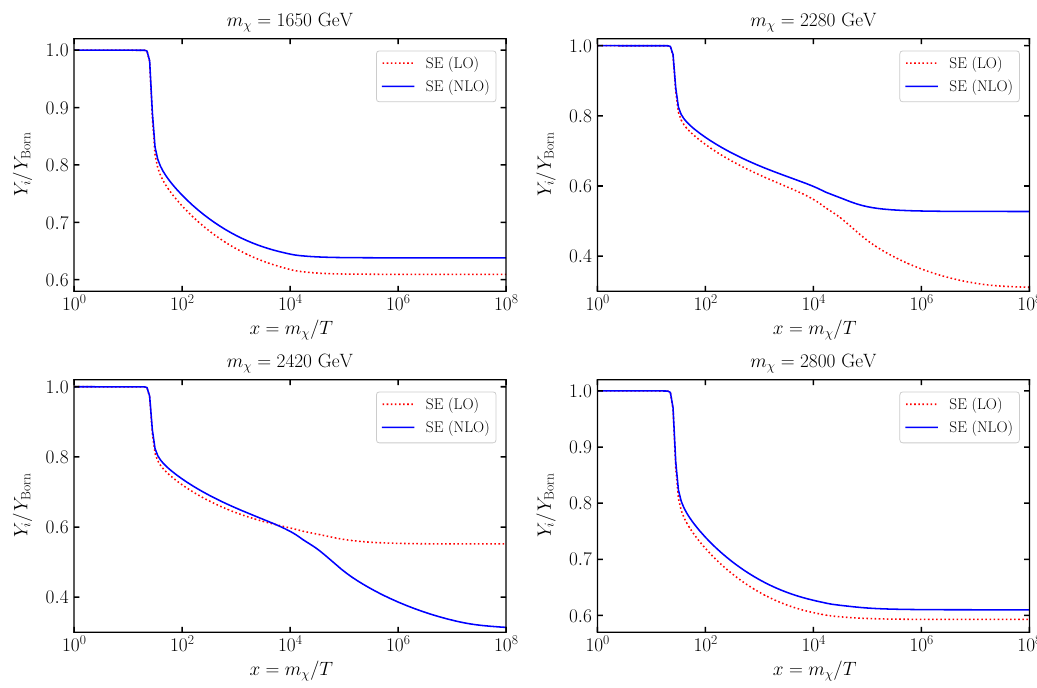
Figure 8 . The ratio Y i /Y Born as a function of x = m χ /T for several values of m χ as in figure 7. The perturbative yield Y Born is computed with the Born cross section only, while the Y i include the LO (dotted/red) and the NLO Sommerfeld potential